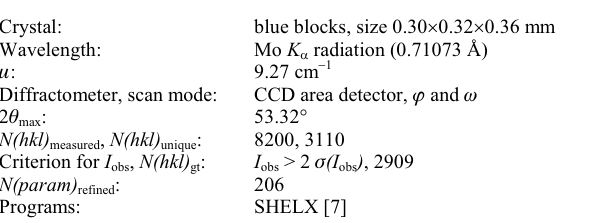
Table 1. Data collection and